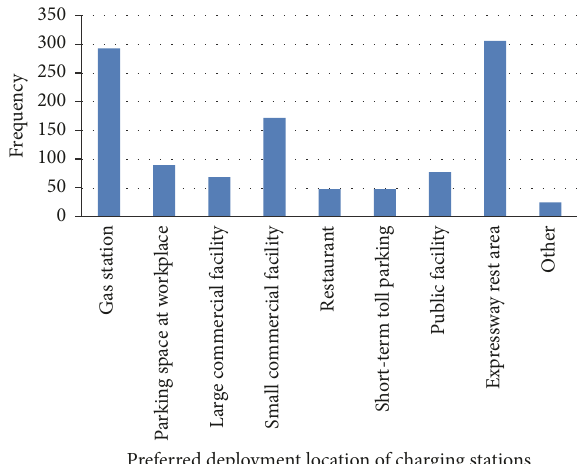
Figure 1: Preferred deployment of charging stations (maximum three